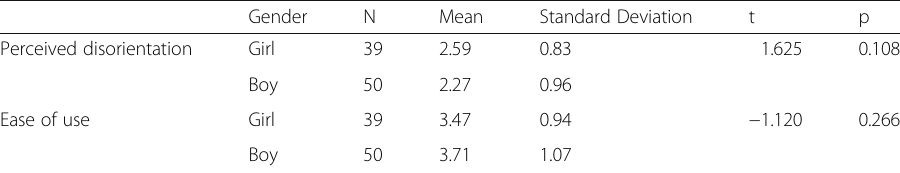
Table 3 T test results for effect of gender to perceived disorientation Gender N Mean Standard Deviation